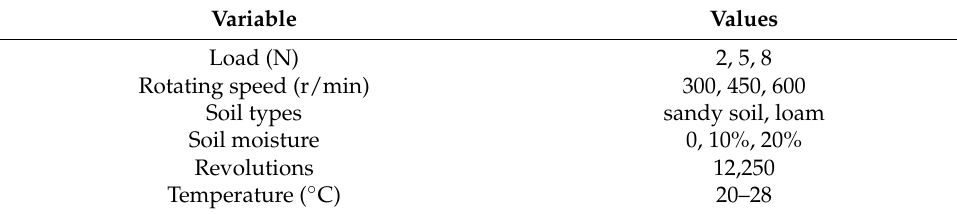
Figure 3. The pin and disk.